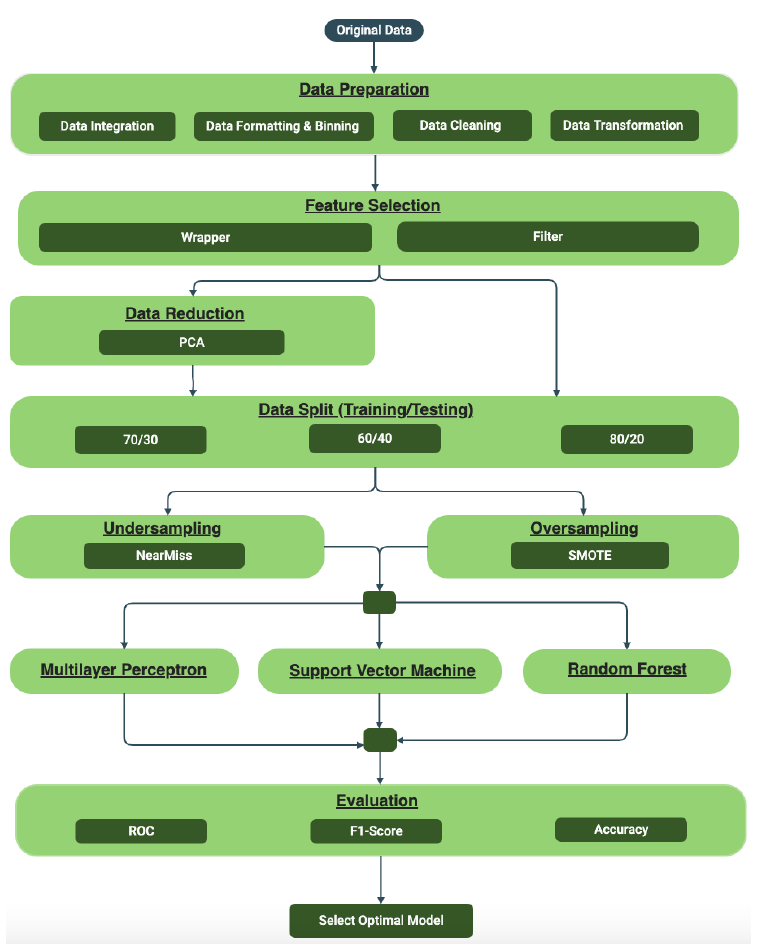
Figure 2. Steps involved in optimal model